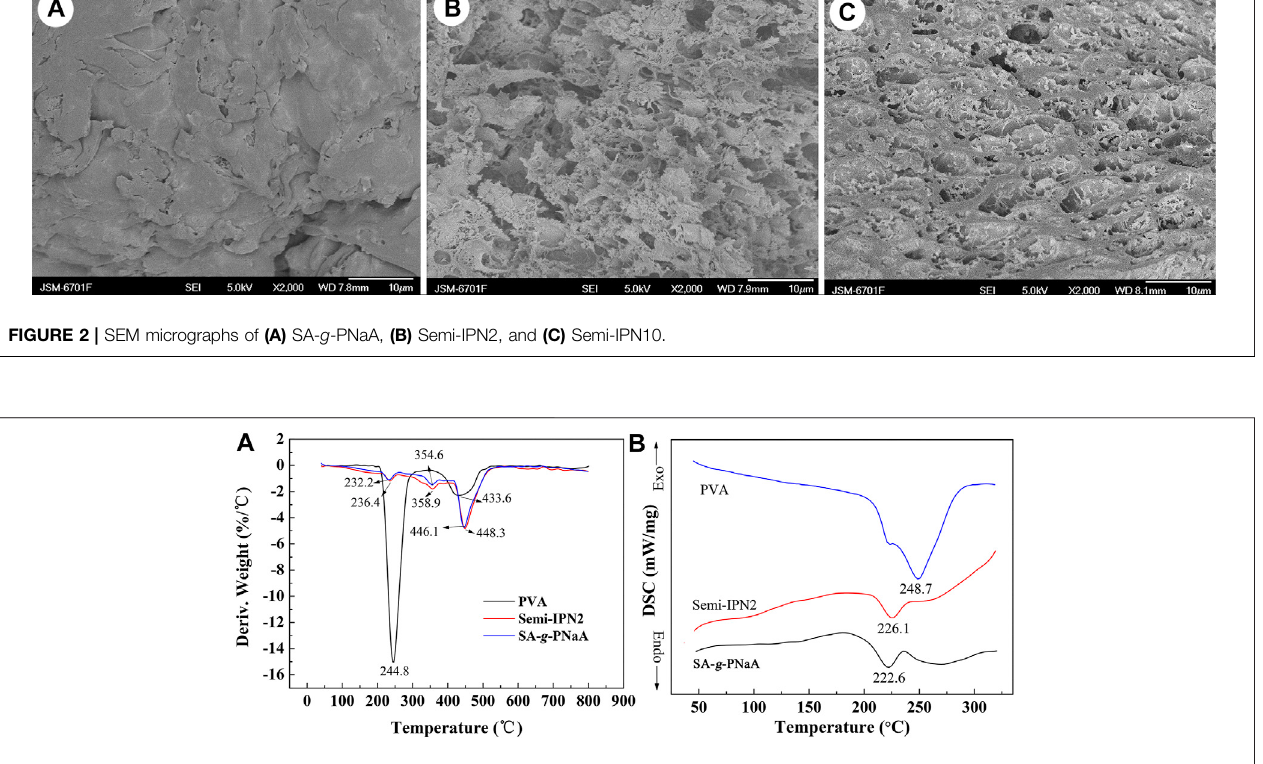
FIGURE 3 | DTG curves (A) and DSC curves (B) of PVA, SA- g -PNaA and Semi-IPN2 adsorbent.